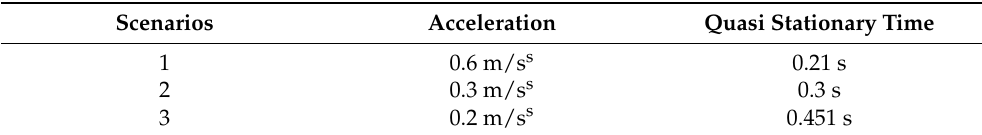
Figure 6. The percentage relative errors of the RMS-DS for various accelerations. Table 3. Quasi stationary time for varying